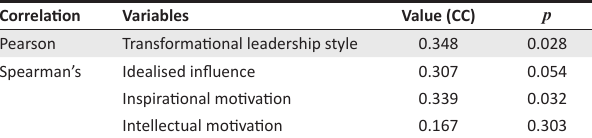
TABLE 7: Goal internalisation and transformational leadership style.